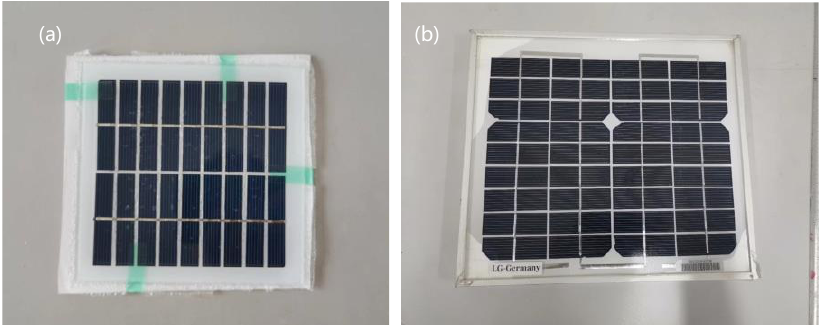
Figure 5. Experimental sample ( a ) Polycrystalline silicon panel; ( b ) Monocrystalline silicon panel.